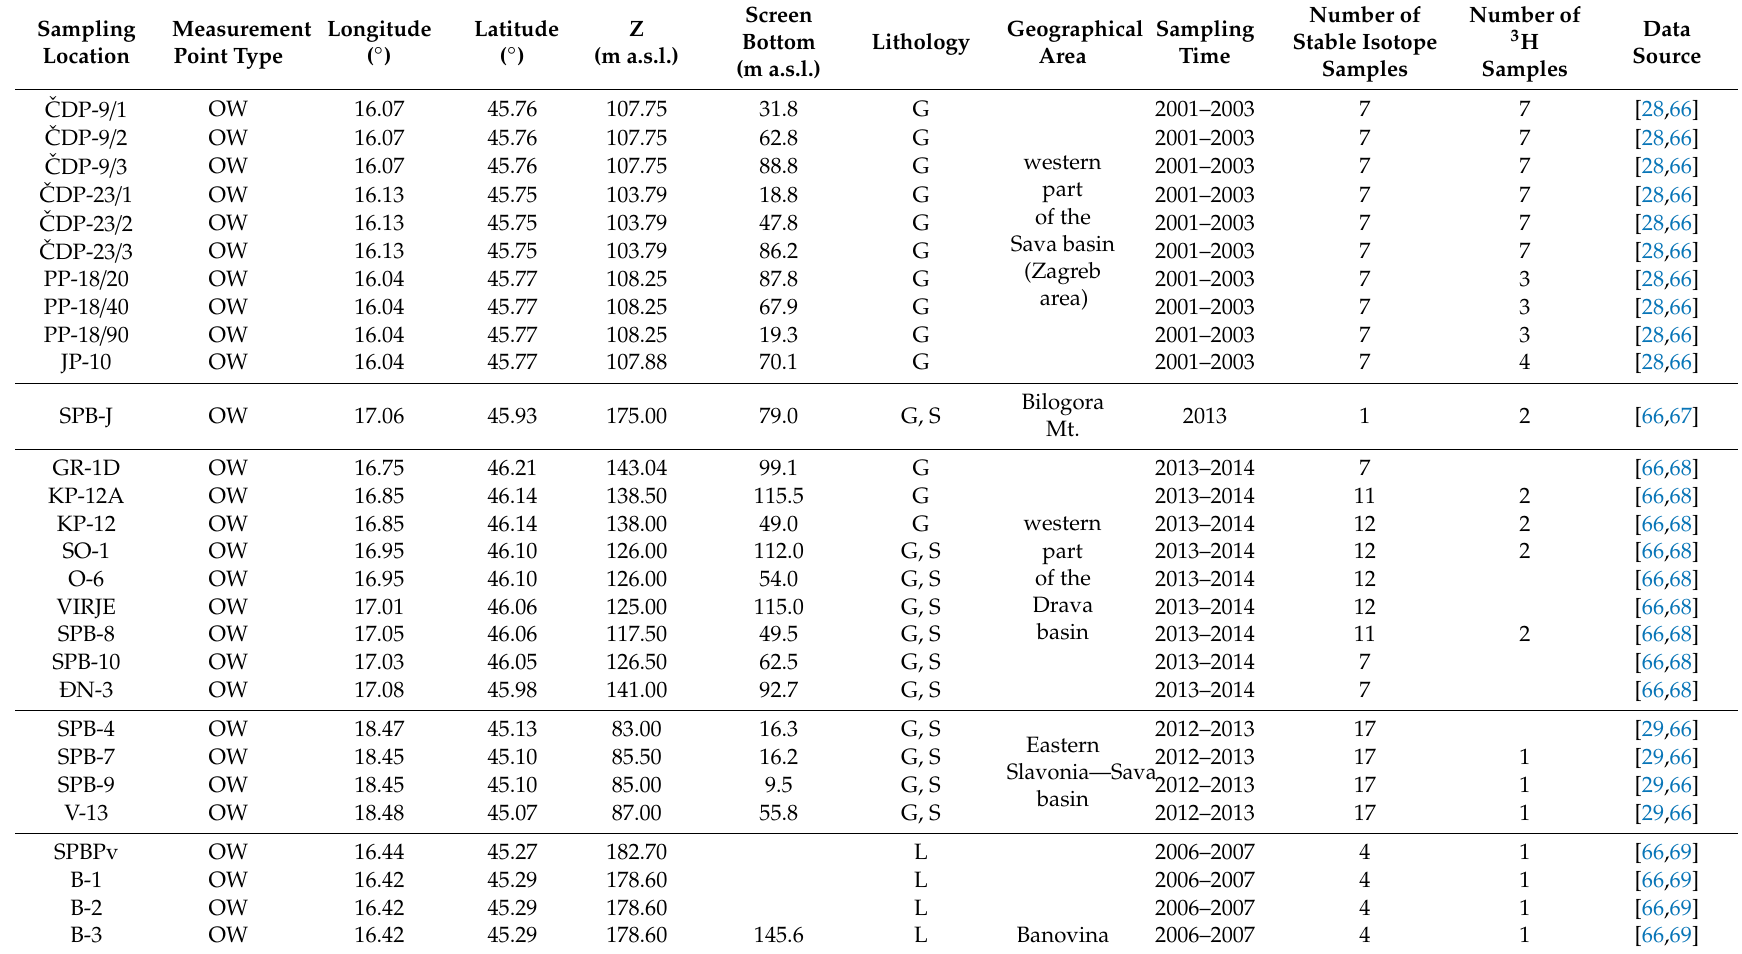
Table 1. Information on the measurement points in the Pannonian part of Croatia. Legend: measurement point type (OW—observation well, S—spring), lithology (G—gravel, S—sand, L—limestone;